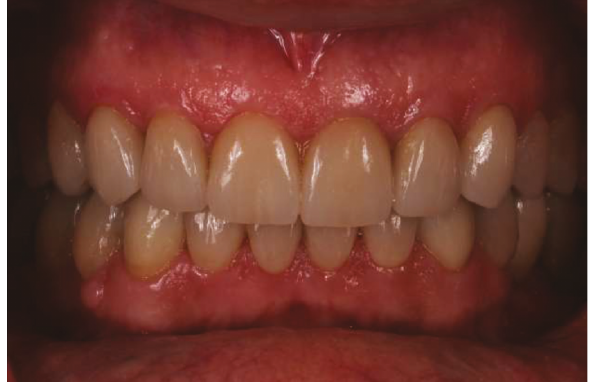
Figure 11: Final intraoral frontal view.